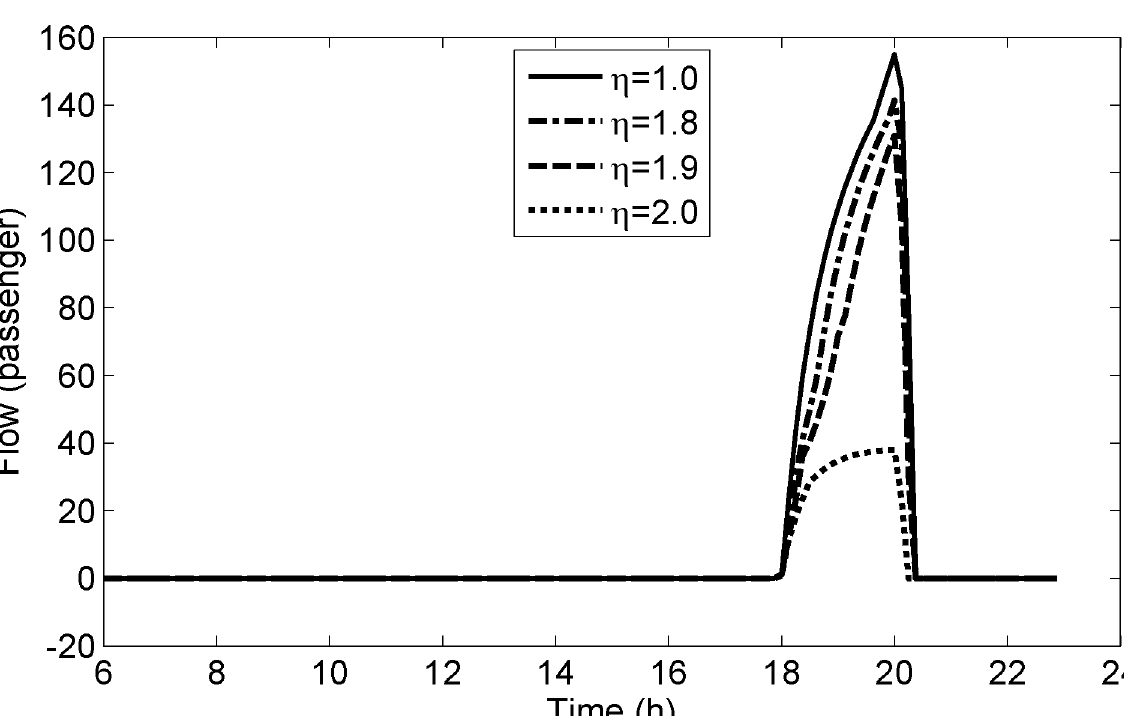
Fig 14. The detained flows of platform s 2